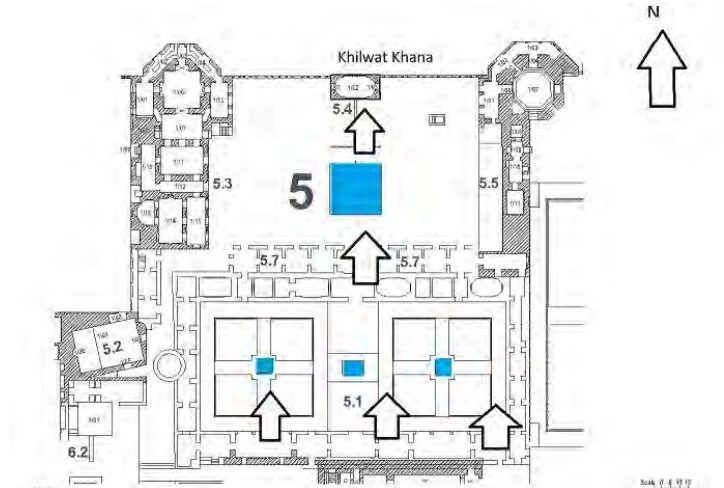
Figure 7. An illustration of paien bagh quadrangle